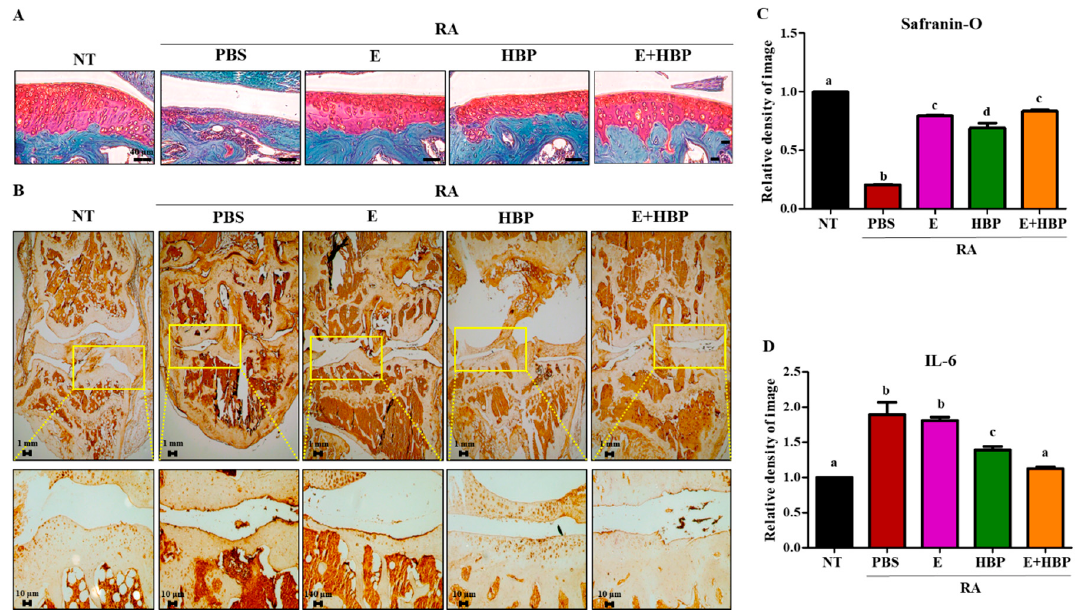
Figure 8. Effects of HBP on cartilage recovery determined via immunohistochemical analysis of IL6 expression and chondrogenic potential via Safranin-O staining. ( A ) Safranin-O-stained cartilage of RA mice. ( B ) IL6 protein in cartilage of RA mice was stained with avidin-biotin. ( C ) Quantification of the degree of Safranin-O and ( D ) IL6 staining of cartilage using Image J software, presented as bar graphs ( n = 10 per group). Different alphabets (a, b, c, and d) in each Figure indicate significant differences among experimental groups ( p < 0.05).